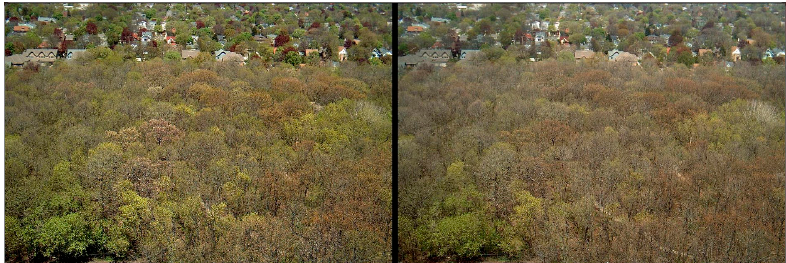
Figure 5. Example of paired images shown to volunteers in Season Spotter. These two images were taken in spring, seven days apart, at the downerwoods site. Green-up has progressed further in the left image.